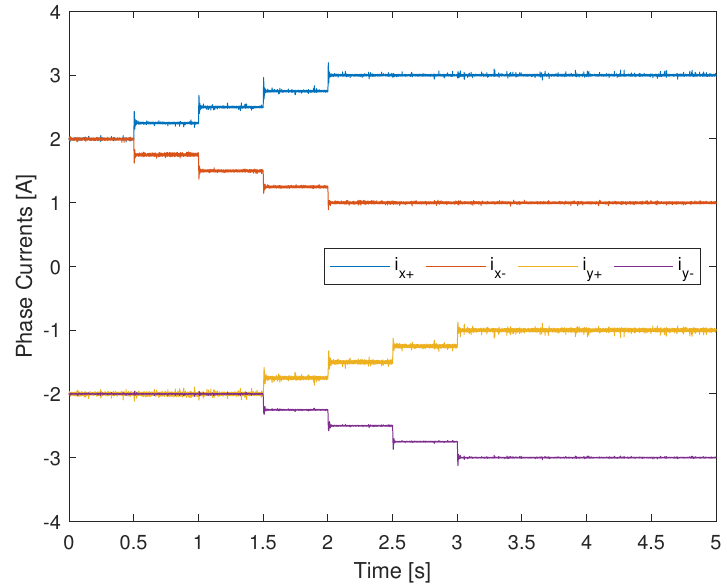
Figure 19. Measured phase currents before